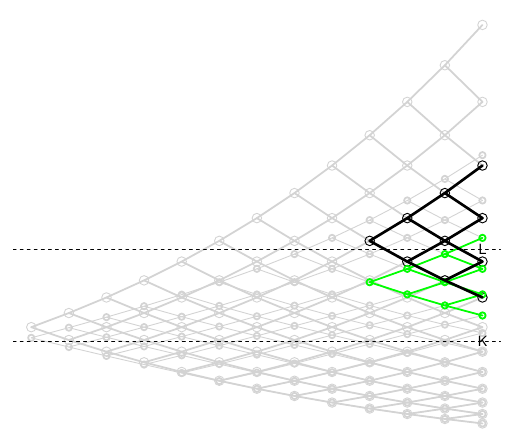
Figure 3. Highlighted subtrees of S ( t ) (black) and S W ( t ) (green) from Figure 1, which demonstrate that S W ( t ) is not a L